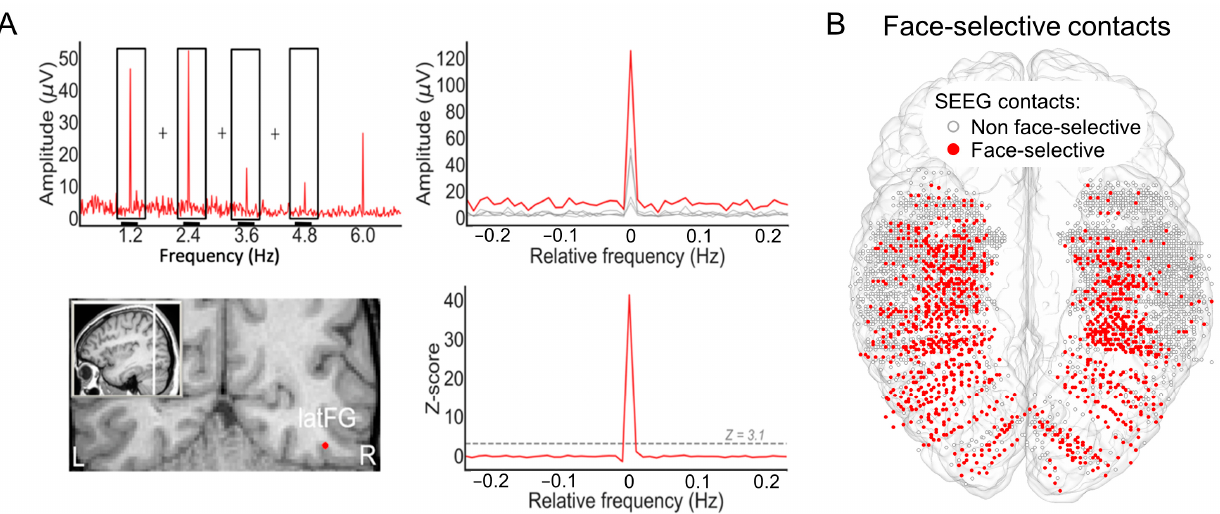
Figure 3. ( A ) Procedure used to define significant face-selective recording contacts inside the brain. Top-left: Intracerebral response measured at a single recording contact (see location on coronal slice – bottom-left) in the frequency domain is show in red. Response significance in defined for each recording contacts typically based on the amplitudes at their first four harmonics (up to 4.8 Hz here). Quantification takes into account more harmonics [37,60] even though the bulk of the signal is found at the first harmonics [43,52]. The frequency spectrum is segmented into four segments containing the amplitudes at relevant harmonics and neighboring frequency bins (top-left, depicted as black rectangles). The spectrum segments (gray lines in top-right panel), containing the signal and the surrounding noise are summed (red line in top-right panel), and a Z-score is then derived at each frequency bin based on the iEEG noise estimated from neighboring bins [62]. ( B ) Significant contacts (e.g., Z-score > 3.1) across individual brains (here, N = 84) are displayed on a template brain (Colin27 brain in the Talairach space).